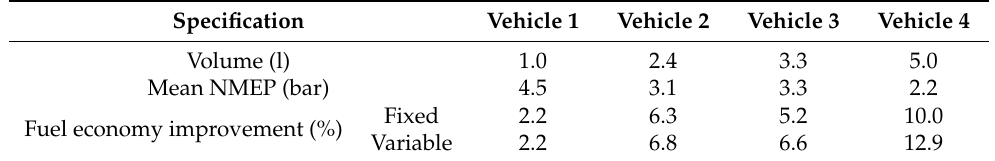
Table 3. Summary of fuel economy improvement under cylinder deactivation for each vehicle in FTP-75.